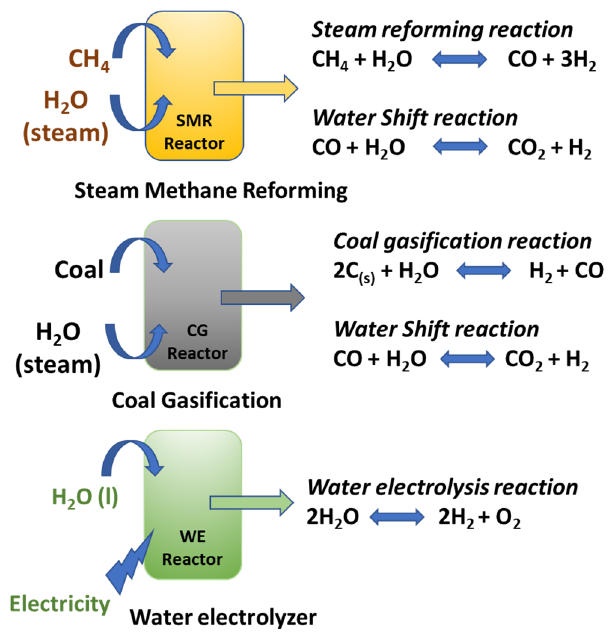
Figure 1. The three major pathways for industrial hydrogen production.